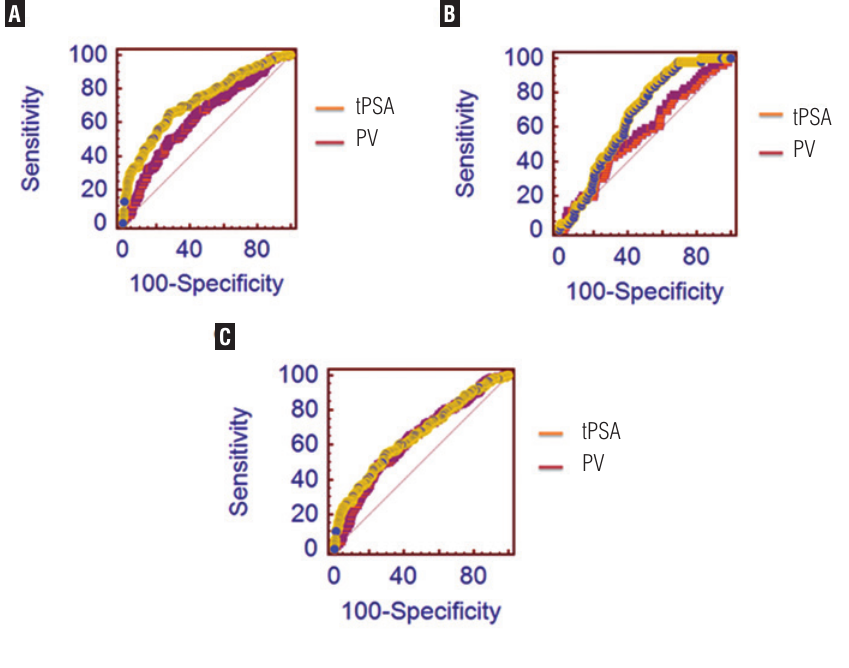
Figure 1 - ROC curves. True positive and false positive rates of PV and tPSA values according to presence of HGPCa. A) The comparison between PV and tPSA in all patients. B) In DRE positive patients. C) In DRE negative